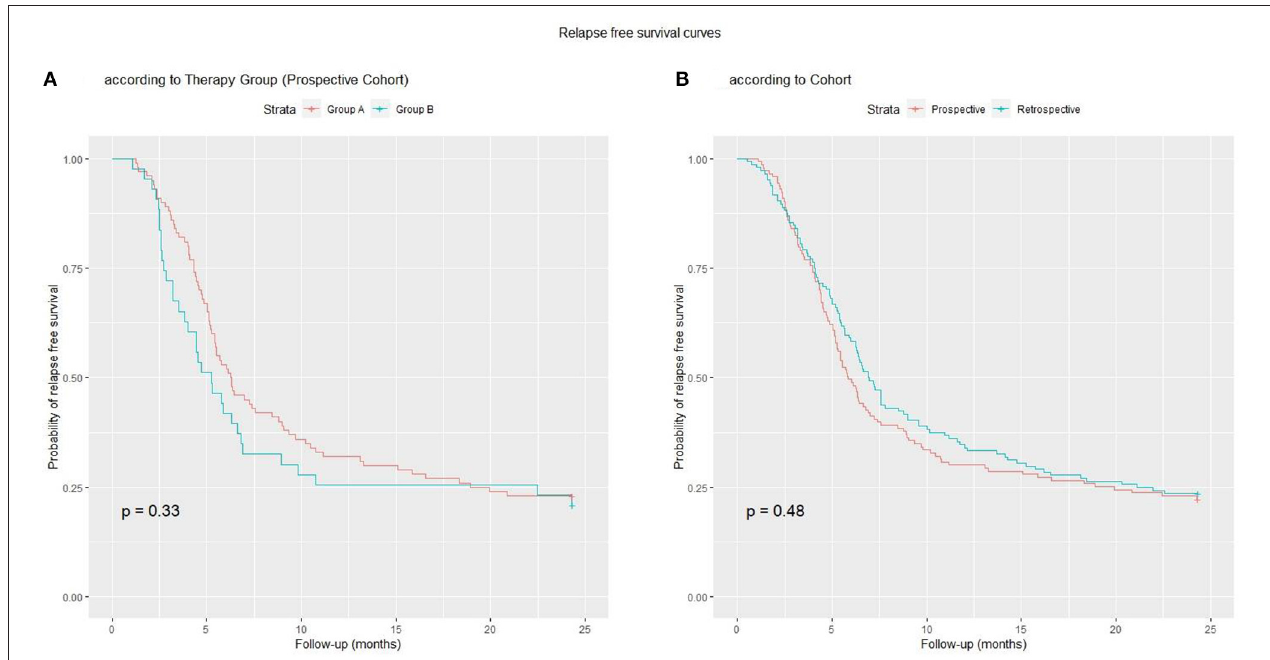
FIGURE 2 | Relapse-free survival curves: (A) Group A vs. Group B; (B) Prospective vs. Retrospective Cohort.